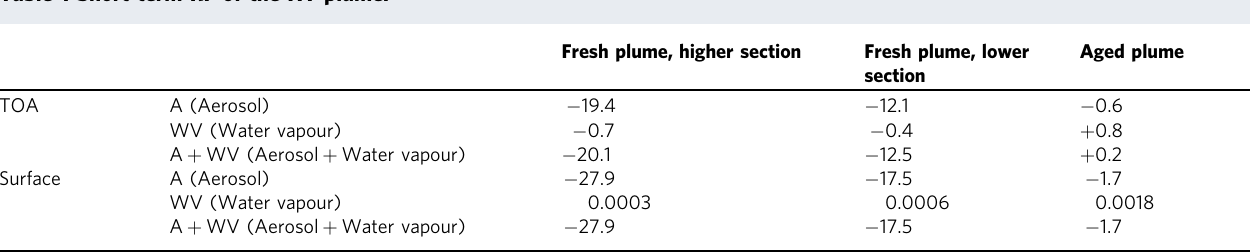
Table 1 Short-term RF of the HT